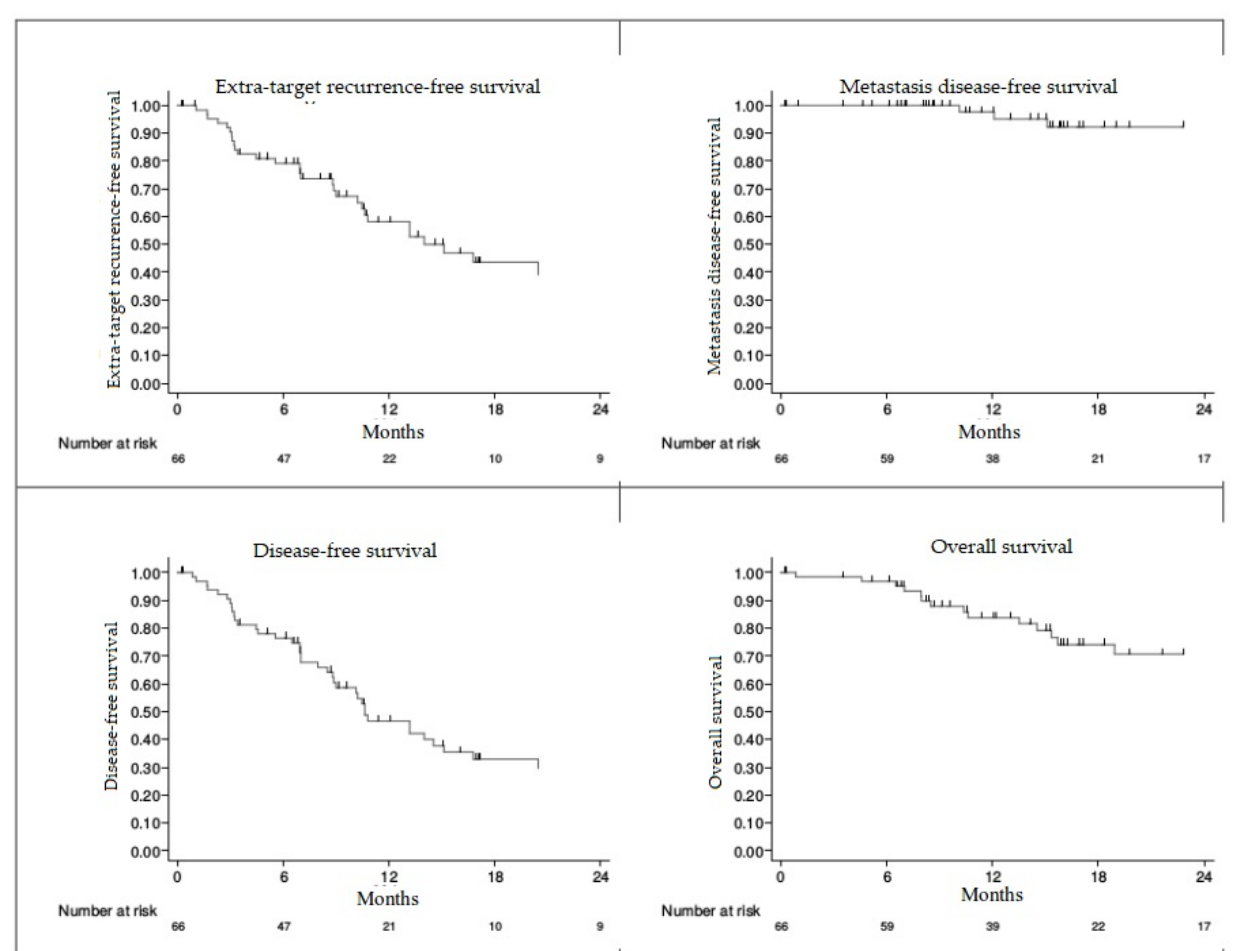
Figure 2. Survival Curves—Kaplan Meier.